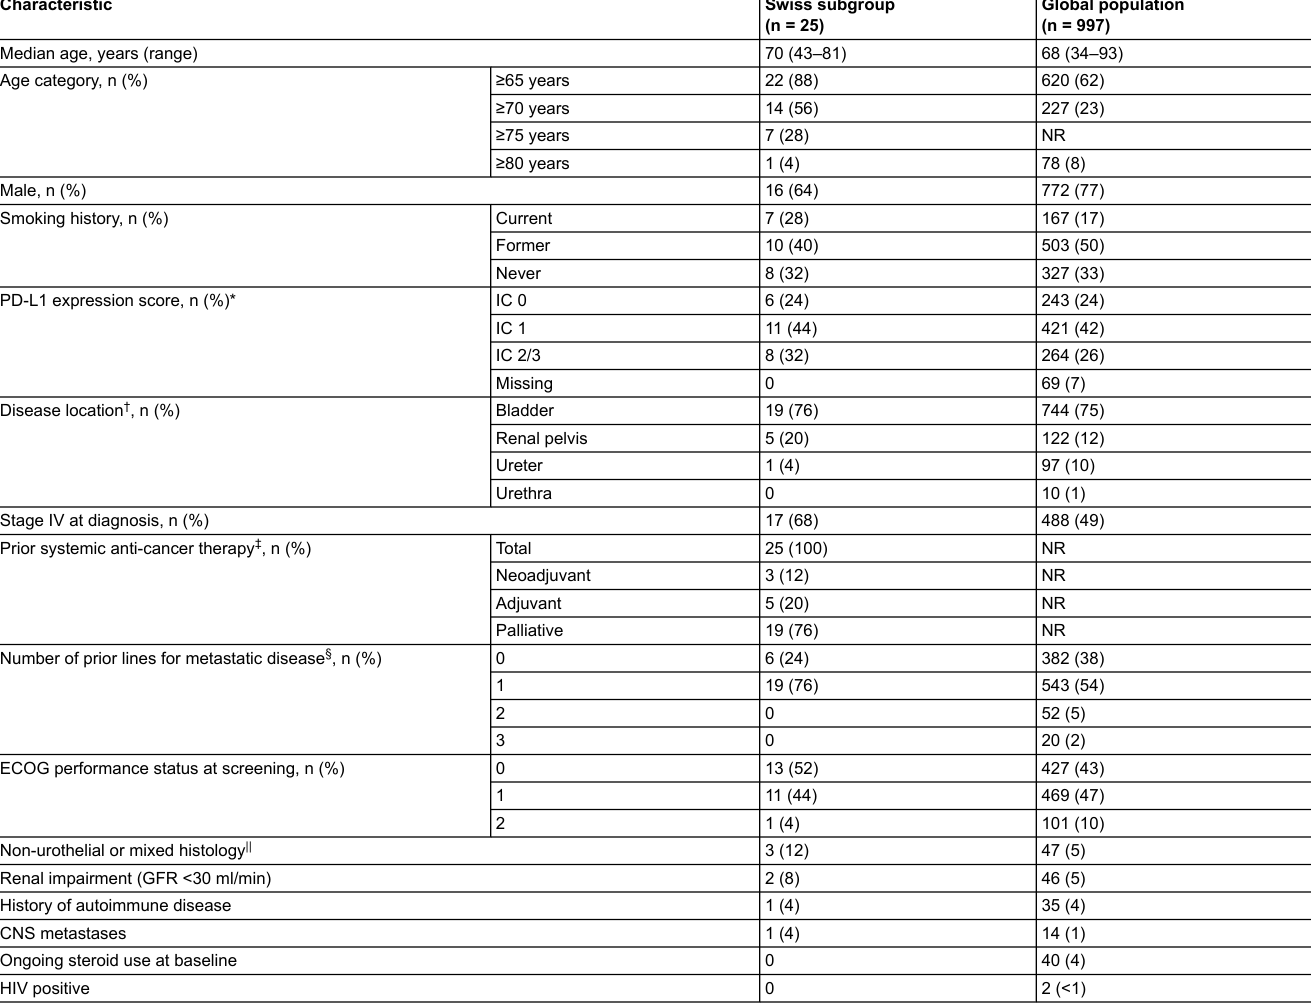
Table 1: Baseline characteristics in the Swiss subgroup and the global population [3, 8, 9].